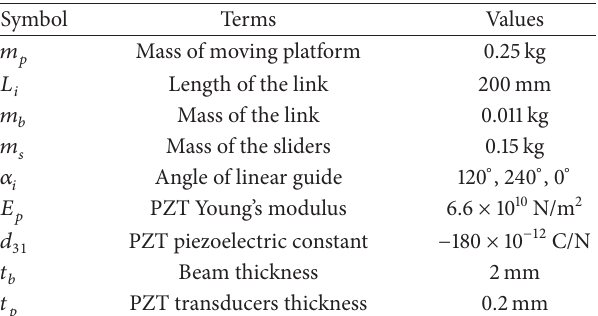
Table 1: Parameters of PPM and PZT